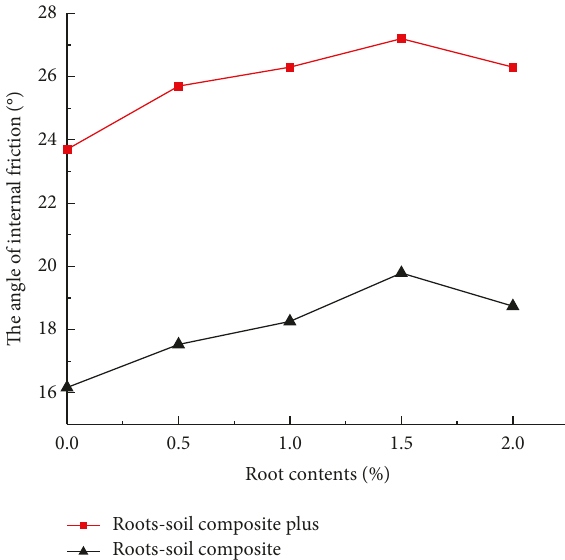
Figure 7: Comparison of internal friction after